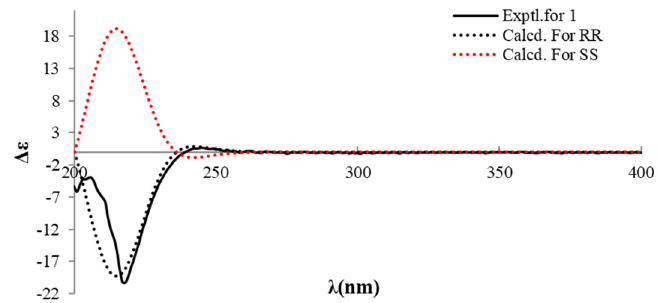
Figure 4. Experimental and calculated ECD spectra of compound 1 .